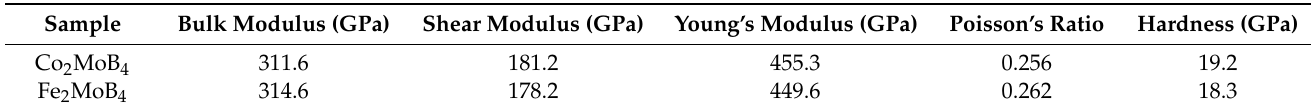
Table 3. The calculated bulk modulus, shear modulus, Young’s modulus, Poisson’s ratio and hardness of Co 2 MoB 4 and Fe 2 MoB 4 .